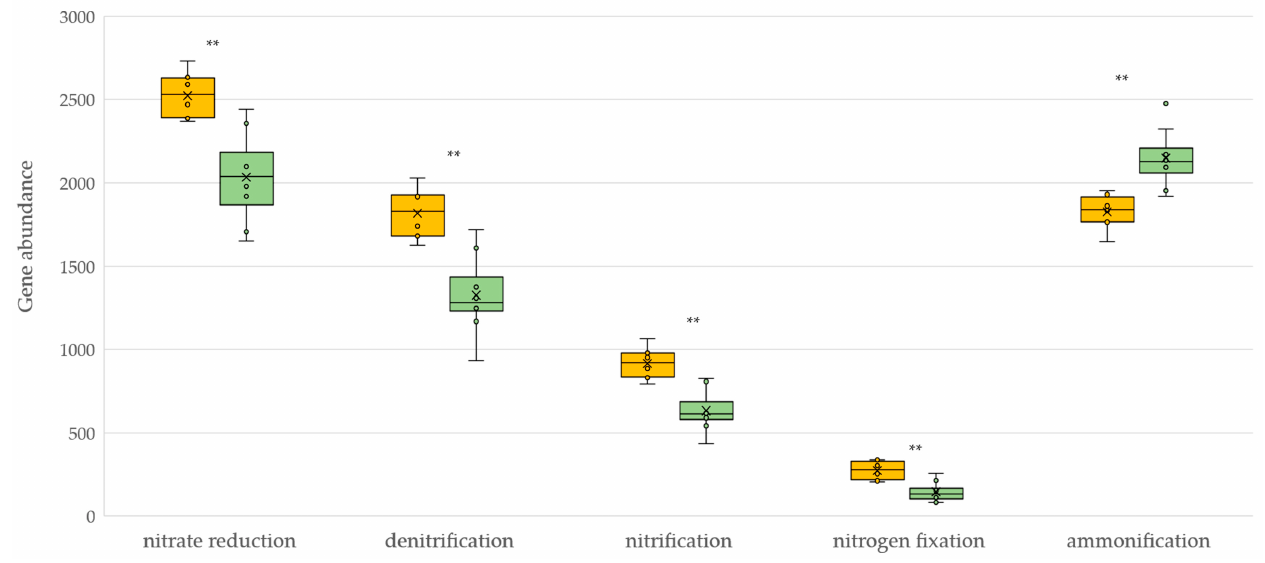
Figure 4. KEGG pathway molecular functions of nitrogen cycle for soils under conventional (yellow)